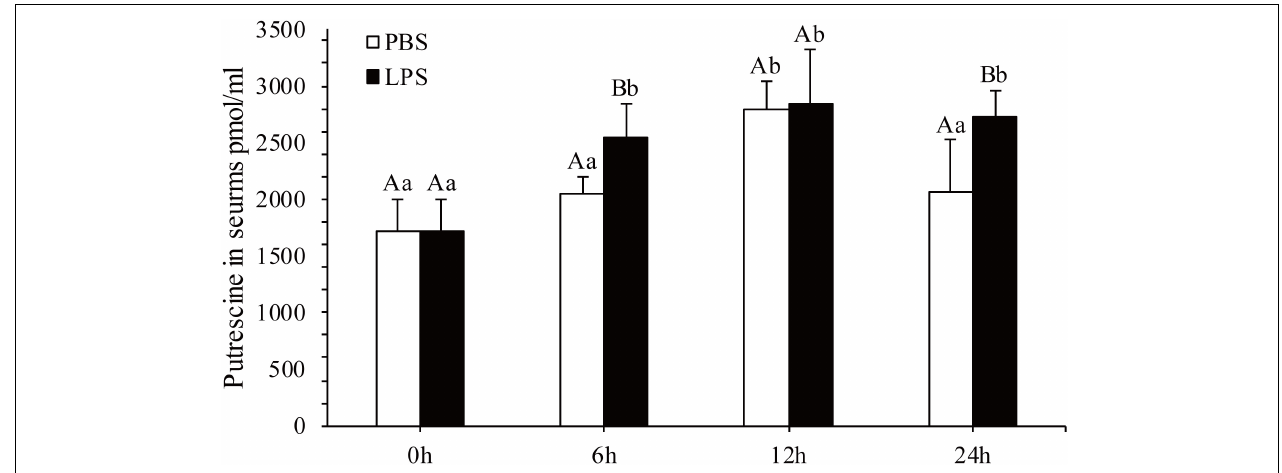
FIGURE 1 | Detection of the putrescine level in serum after lipopolysaccharide (LPS) stimulation. Values are shown as mean ± SE ( N = 5). Lowercase letters represent differences at different time points in the same groups, and capital letters represent differences in the different groups at same time points.